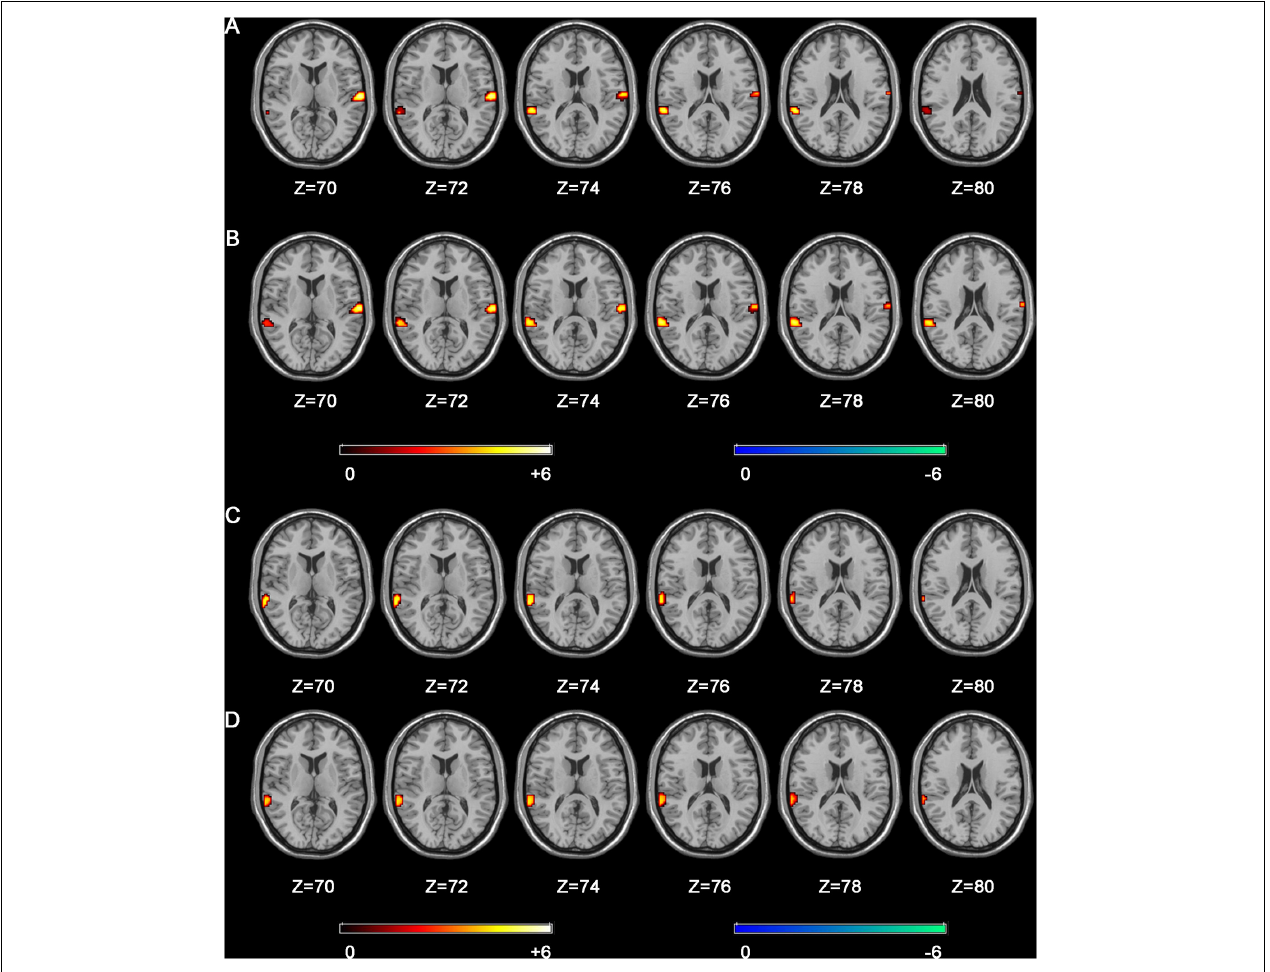
FIGURE 3 | Comparison of brain activity during the experimental task when Chinese and Western-trained musicians listened to music with familiar and unfamiliar styles compared to non-musicians. Compared to non-musicians, Chinese-trained musicians have greater activation of the bilateral superior temporal gyrus, and Western-trained musicians have greater activation of the left superior temporal gyrus. (A) Chinese-trained musicians – music with Chinese style. (B) Chinese-trained musicians – music with Western style. (C) Western-trained musicians – music with Chinese style. (D) Western-trained musicians – music with Western